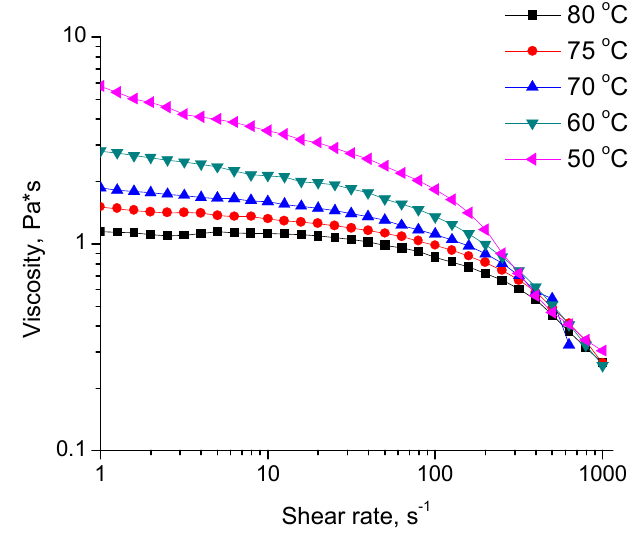
Figure 8. Flow curves of the 6% κ-carrageenan dispersion at different temperatures.